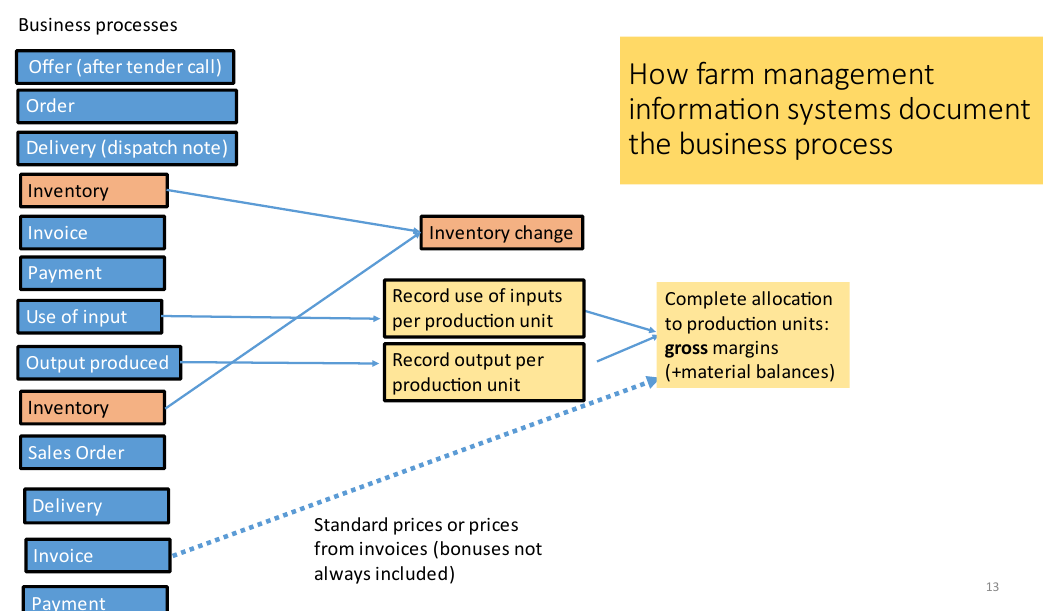
Figure 3. How Farm Management Information Systems document the business process.